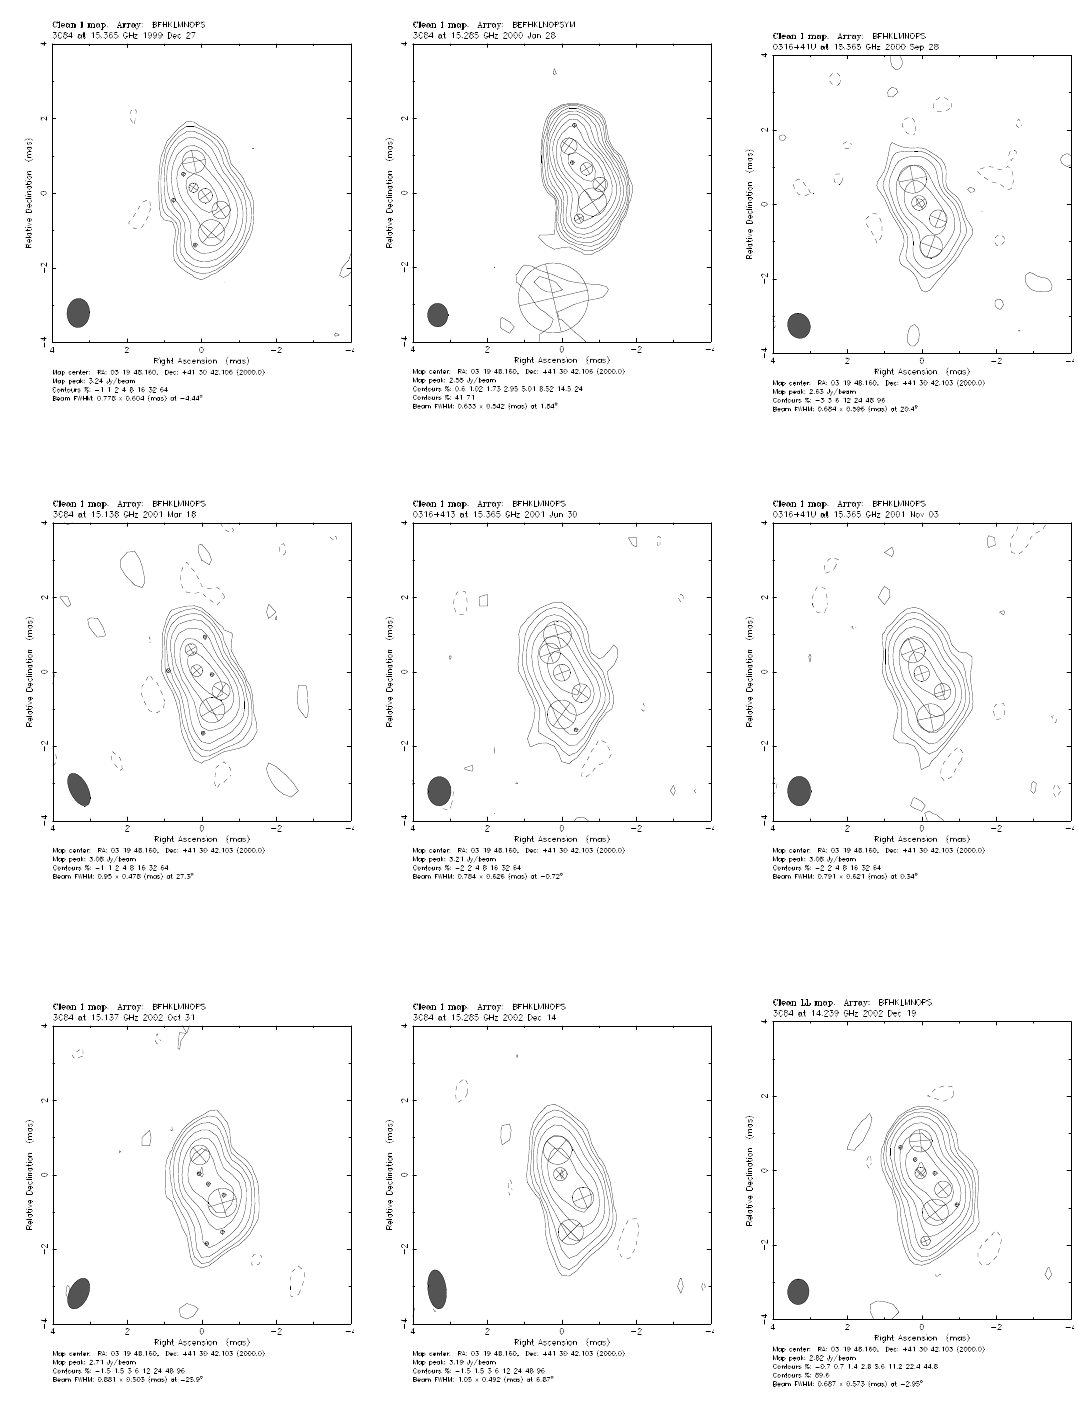
Figure A1. VLBA images superimposed by Gaussian circular components. Their parameters have been derived within the difmap -modelfit programme. The epochs are: December 1999—February